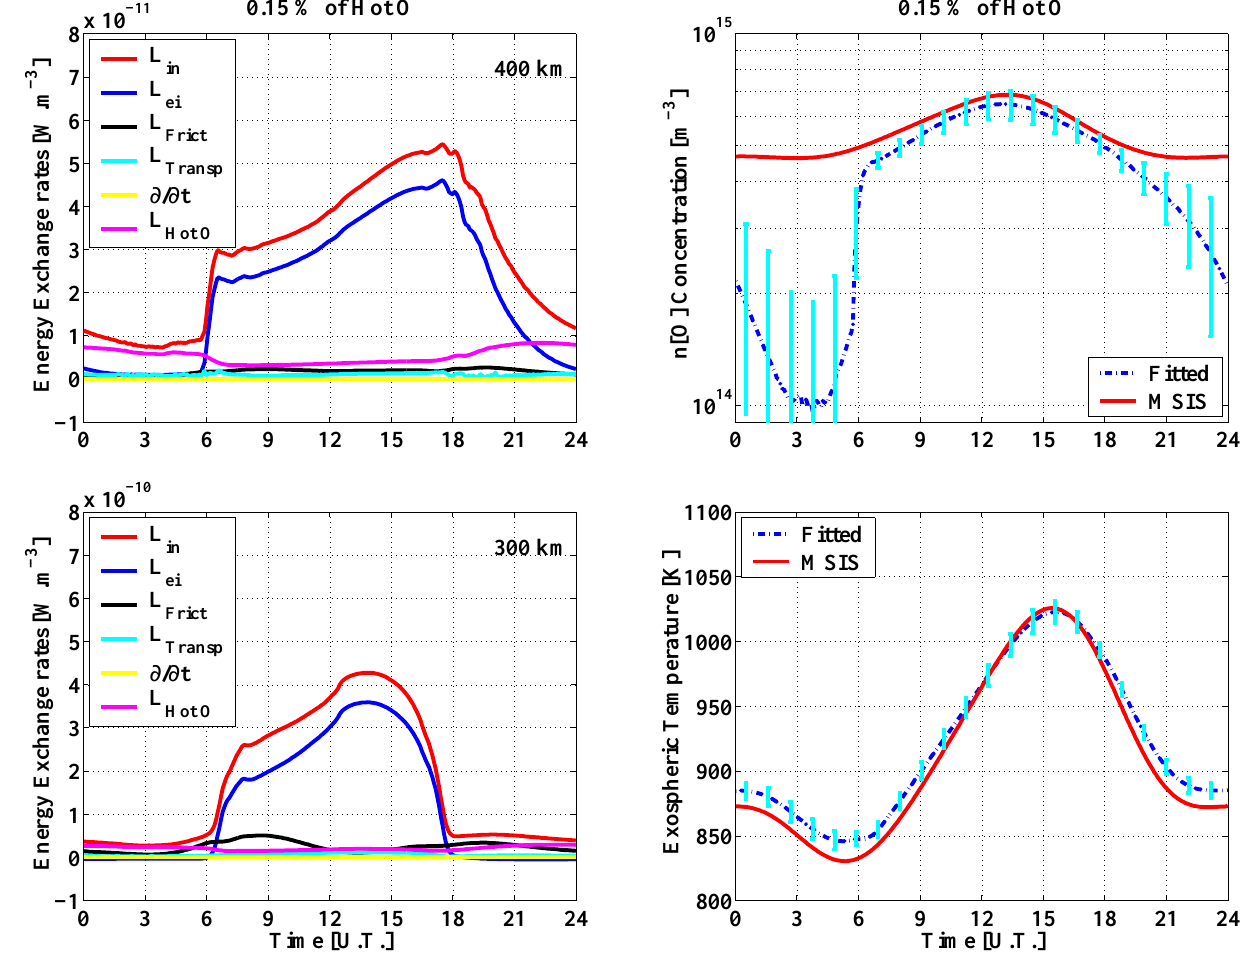
Fig. 4. Same as Fig. 2, but a population of hot O has been added to the standard MSIS neutral atmosphere: Hot O concentration is kept constant vs. time such that at noon { n [ O Hot ] /n [ O ]} 400km = 0 . 15%; its altitude profile is defined with an equivalent exospheric temper- ature of 4000 K.